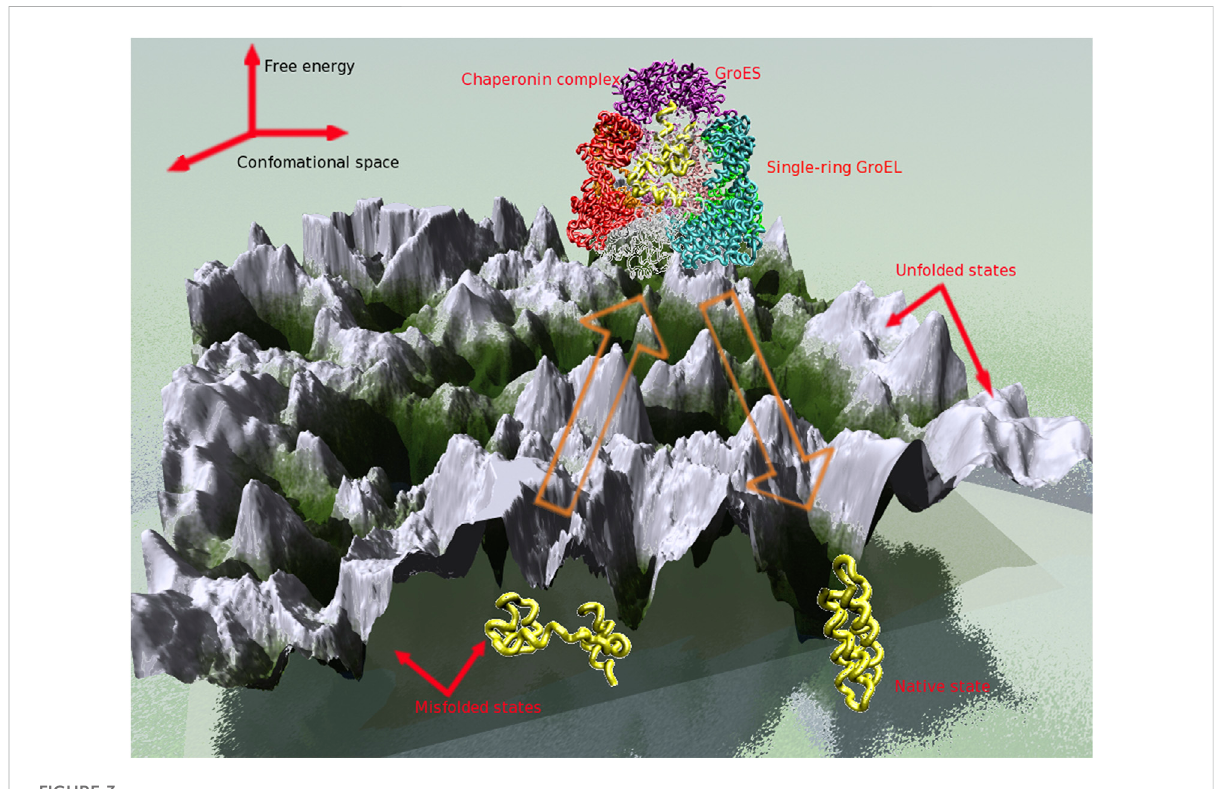
FIGURE 3 Energy landscape perspective of the chaperonin annealing